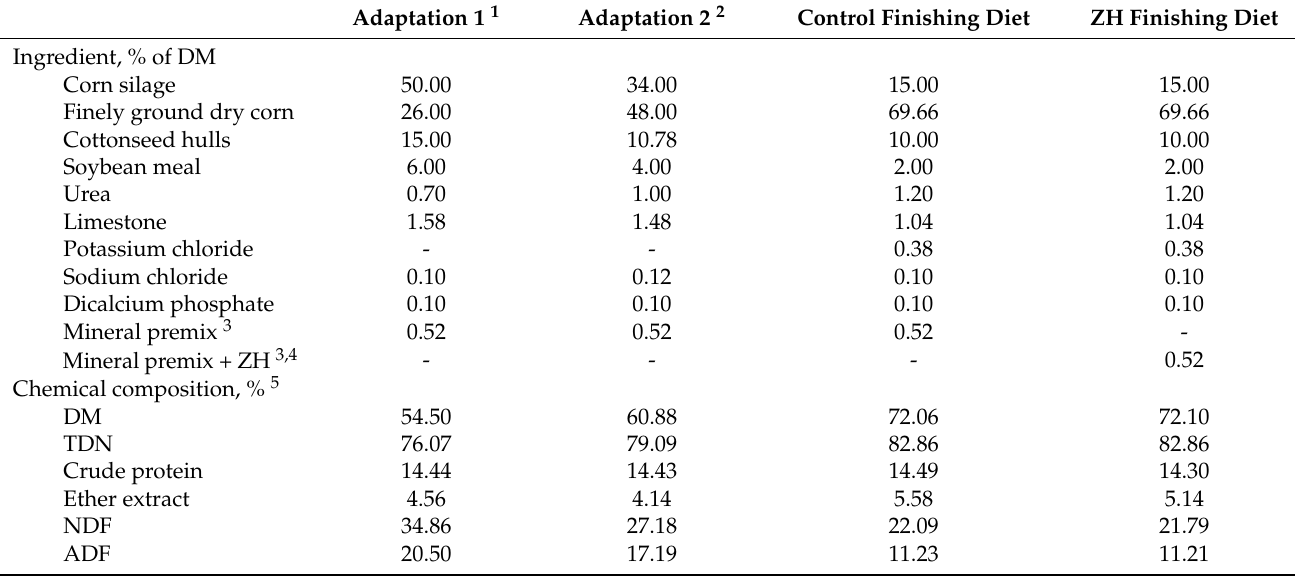
Table 1. Composition of experimental diets (DM